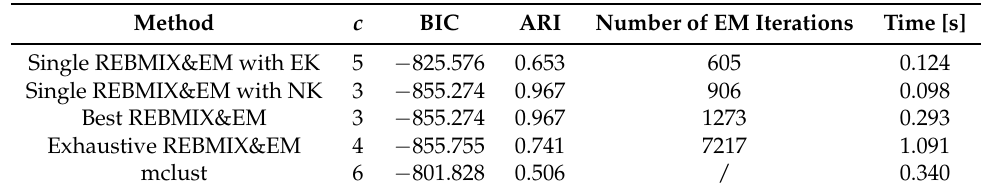
Figure 9. Top-down view of cross dataset from [36]. The first plot gives the unlabeled observations; the second plot gives the true two-cluster clustering; and the third plot gives the ideal three-cluster clustering. Table 5. Results on the cross dataset from [36].